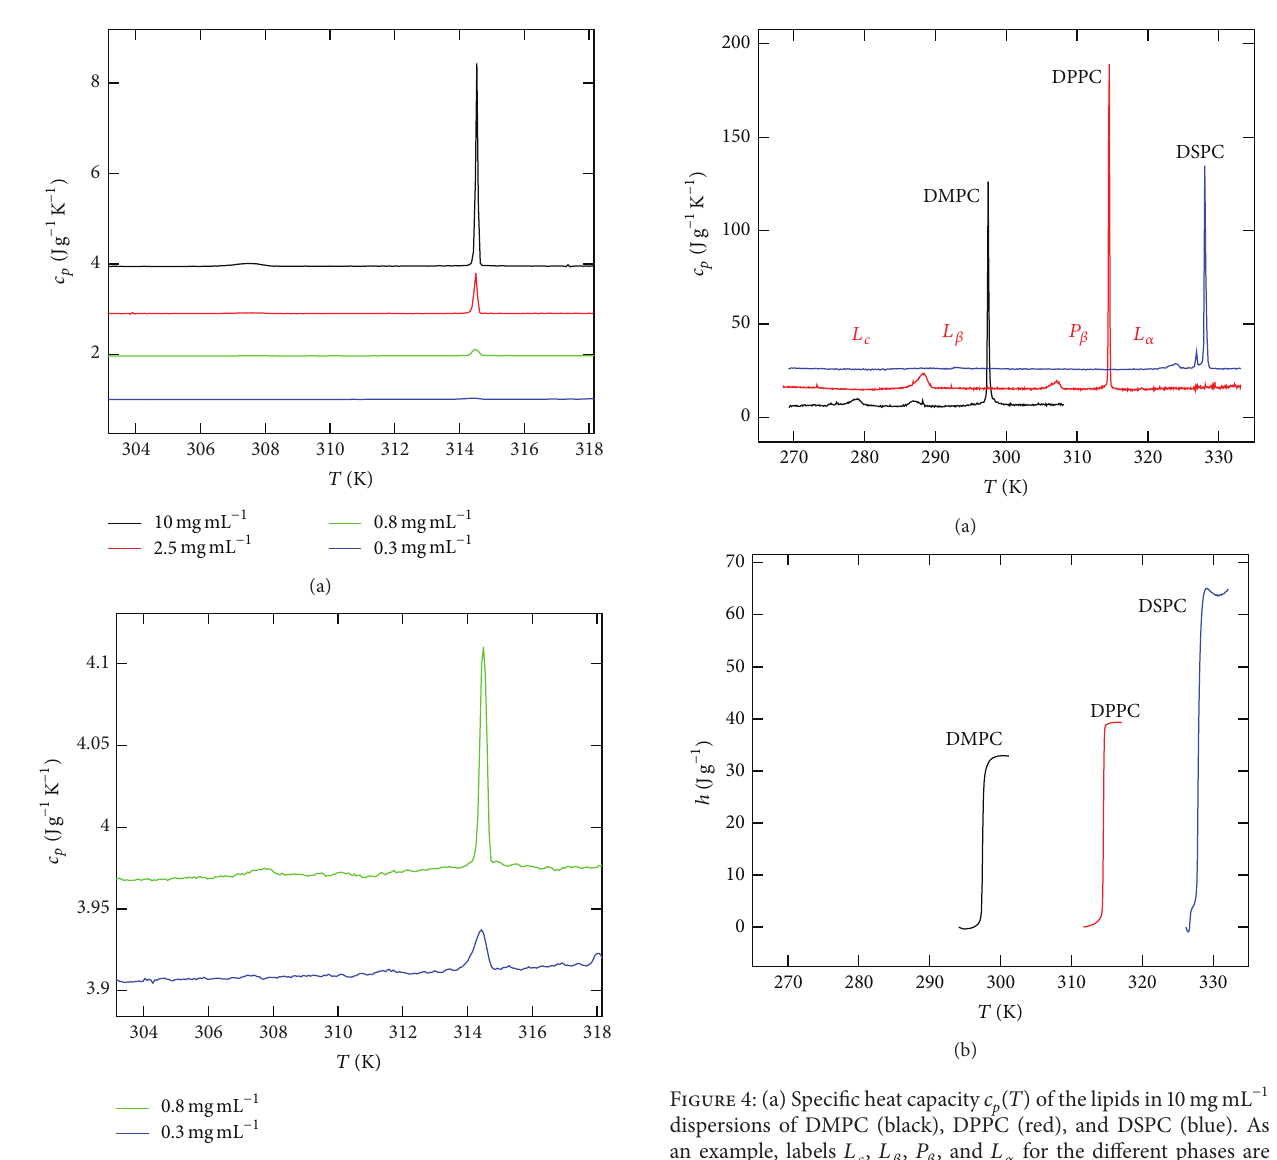
dispersions of DMPC (black), DPPC (red), and DSPC (blue). As , 𝐿 𝛽 , 𝑃 𝛽 , and 𝐿 𝛼 for the different phases are an example, labels 𝐿 c included for DPPC. The 𝑐 𝑝 values for the two last lipids have been shifted upwards for better figure display. (b) ℎ(𝑇) discontinuities at the main phase transition